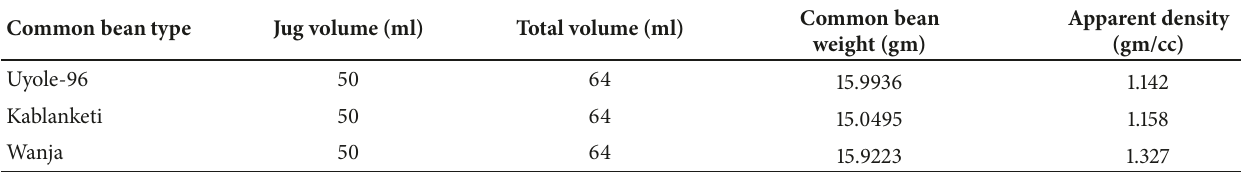
Table 9: Common beans apparent density analysis